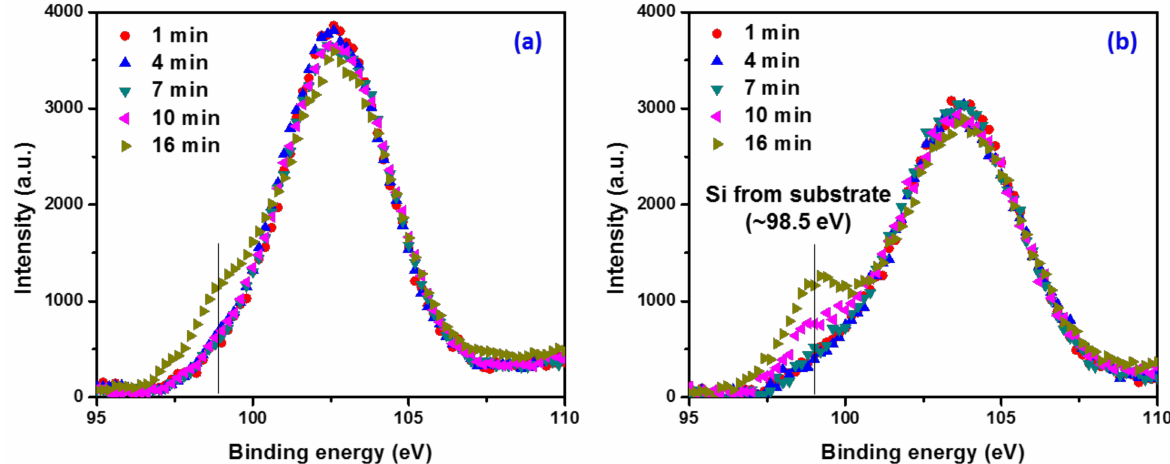
Figure 7. Depth profile of Si atom in vertical direction to the films; ( a ) structural film and ( b ) subtractive